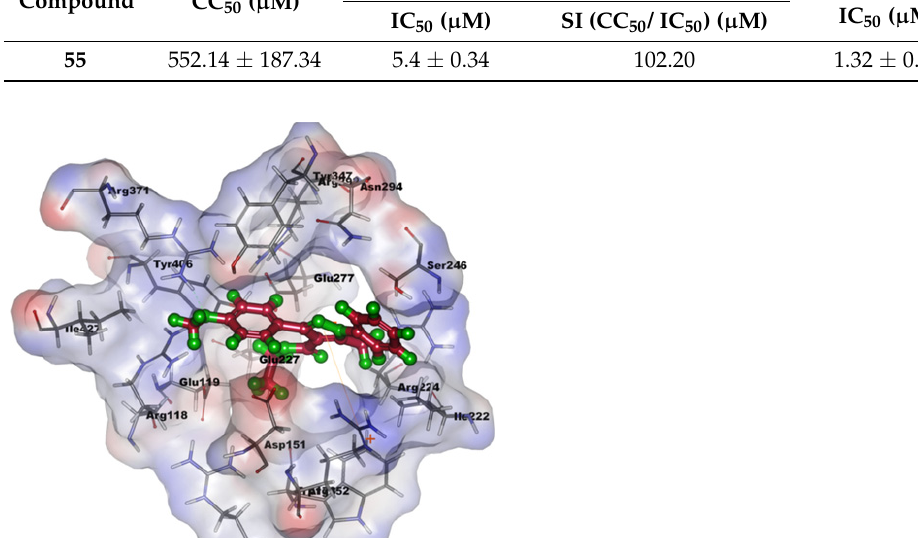
Table 7. The inhibitory activity of compound 55 against influenza H1N1 virus and neuraminidase. Compound